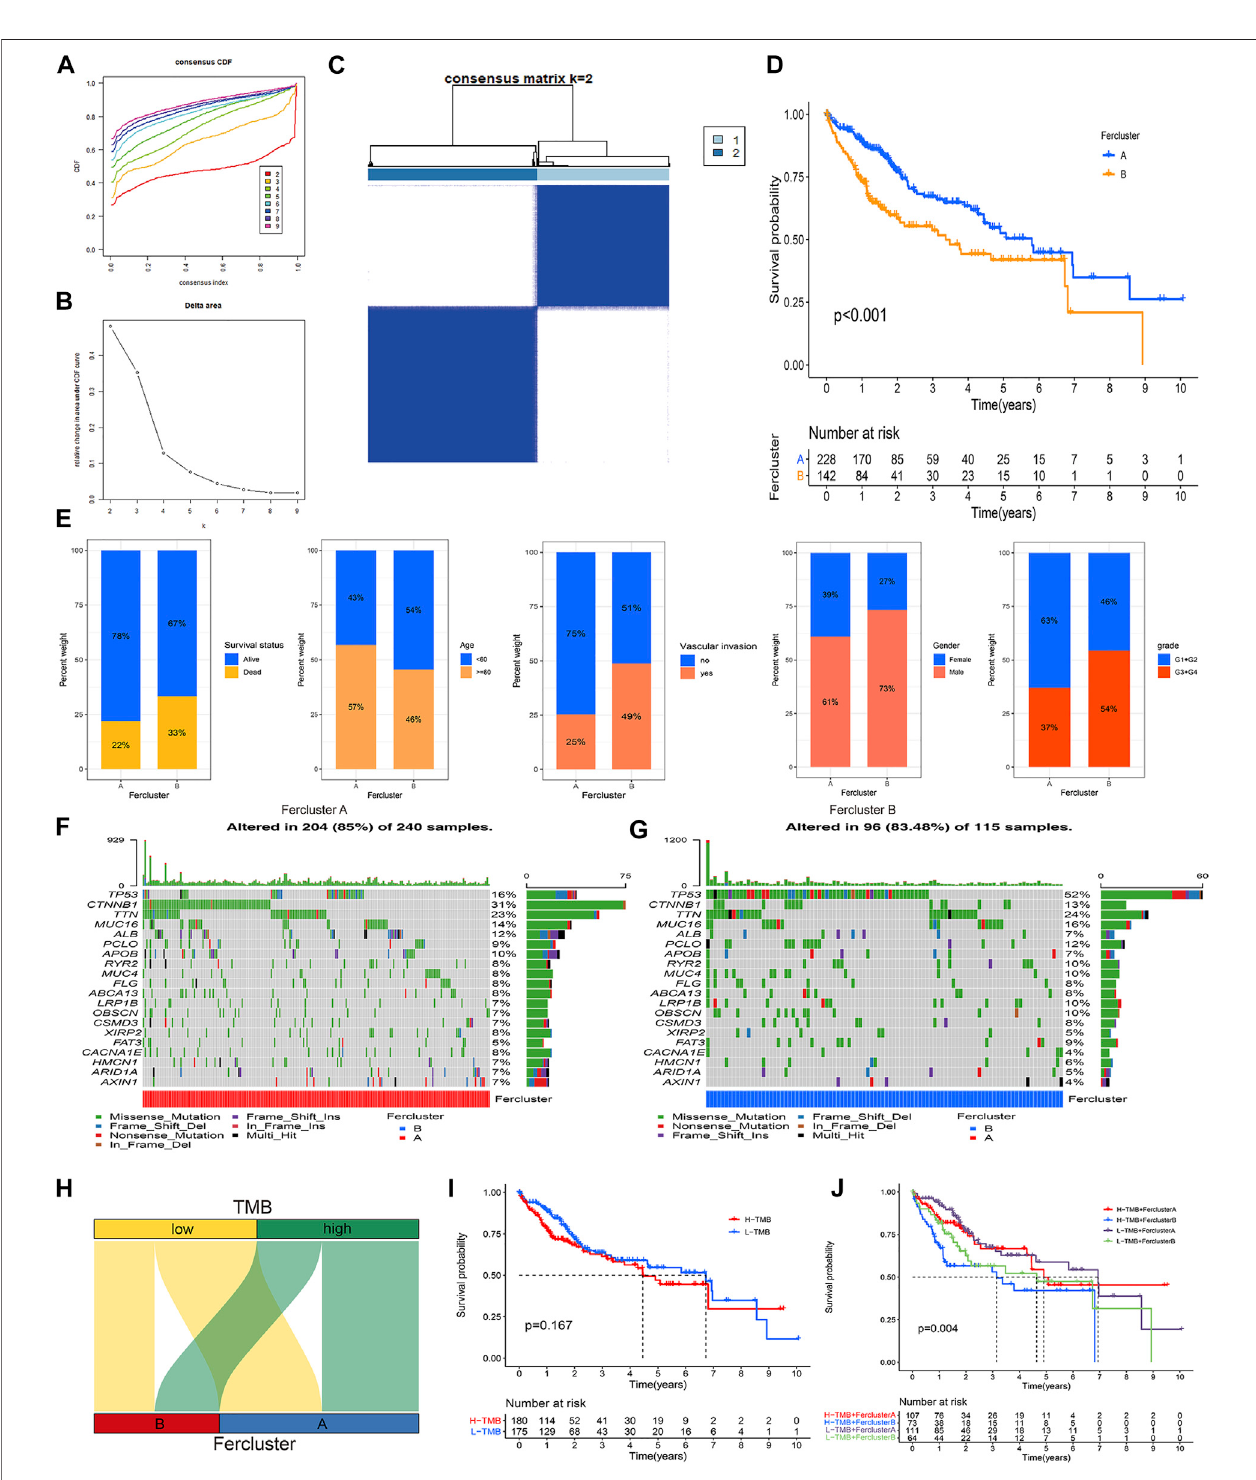
FIGURE2| Establishmentandclinicalassessmentofferroptosis-relatedsubtypesinHCC. (A) Consensuscumulativedistributionfunction(CDF)curveswithkfrom 2 to9. (B) Delta area plot showing the relative change in areaunderthe CDF curvesbetween k and k-1 (k =2 – 9). (C) The result ofconsensus clustering (k value= 2). (D) K-M curve showing the difference in survival probability between fescluster A and fescluster B. (E) Characteristics of clinical features in fescluster A and fescluster B. (F – G) Characteristics of TMB in fescluster A and fescluster B. (H) Venn diagram showing the correlation between TMB and fesclusters. (I) K-M curve showing the difference in survival probability between low and high TMB. (J) K-M curve showing the difference in survival probability among fescluster A with low TMB, fescluster A with high TMB, fescluster B with low TMB, and fescluster B with high TMB.